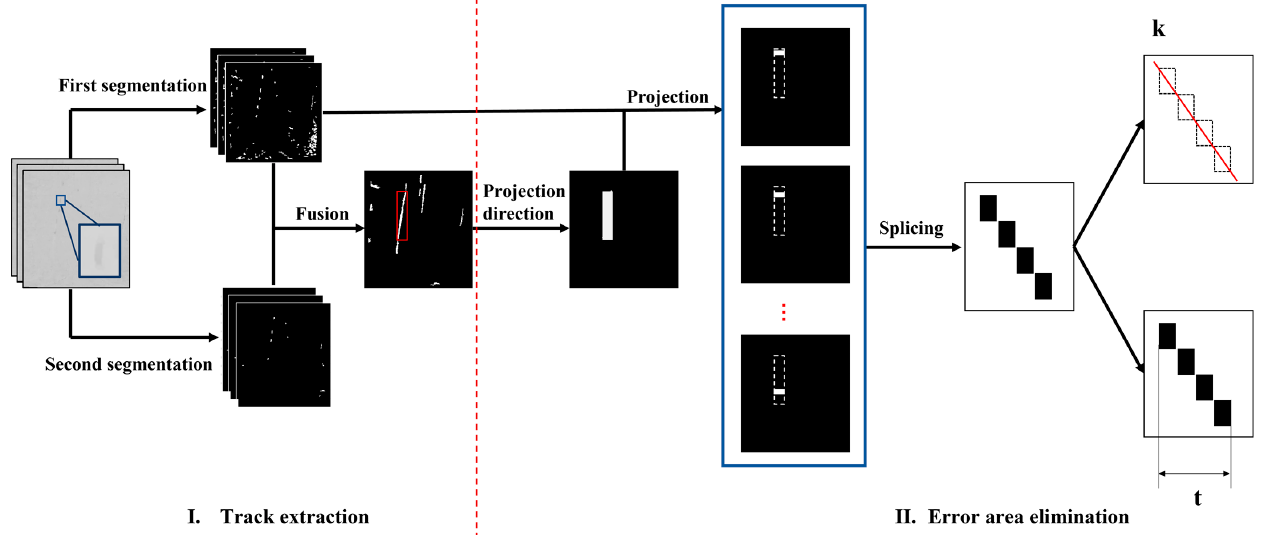
Figure 4. The process of motion-track region extraction.